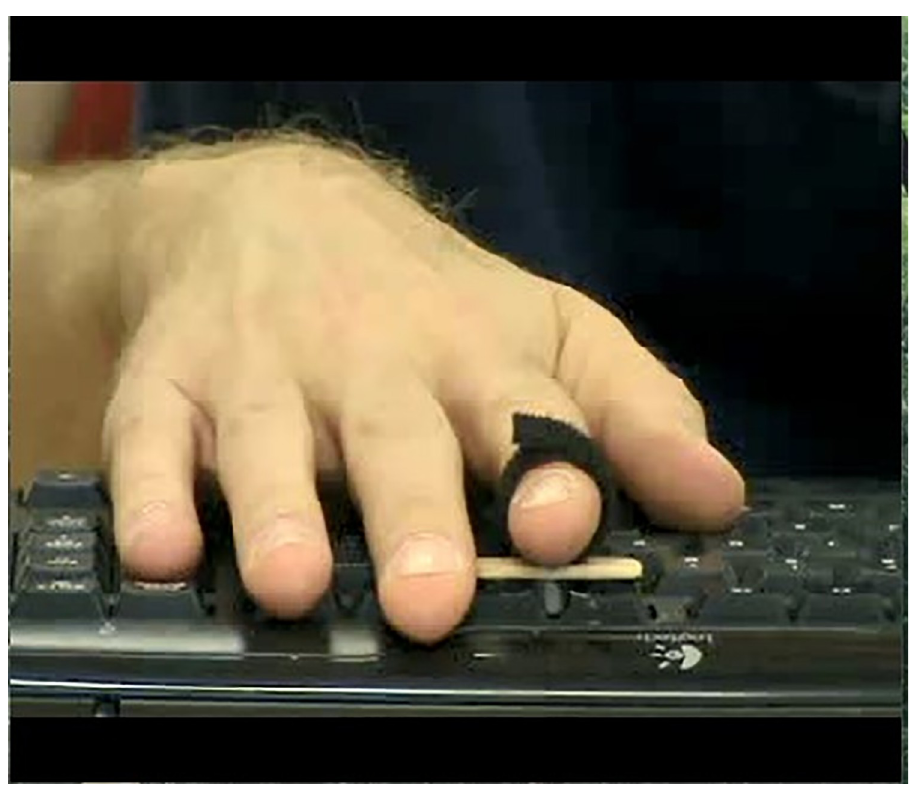
Fig 1. Intentionality bias paradigm. Screenshot of video by Moore and Pope [56] for the intentionality bias